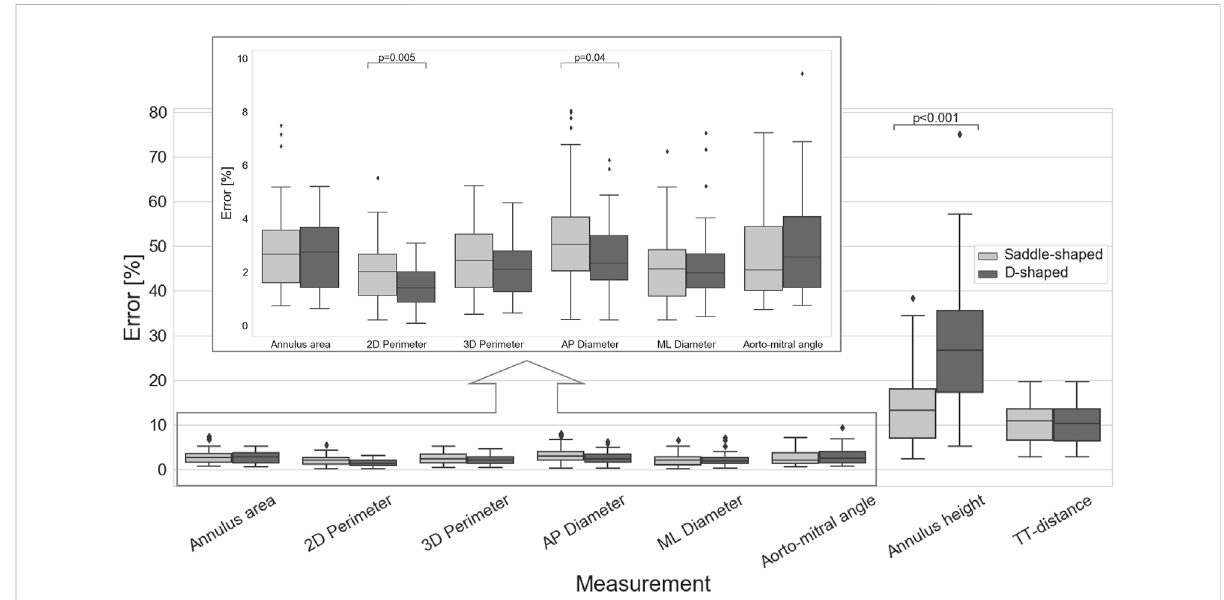
FIGURE 4 Inter-observer variability for the multiple measurements ( p -values are shown for statistically signi fi cant differences between the saddle- and D-shaped annulus curves).